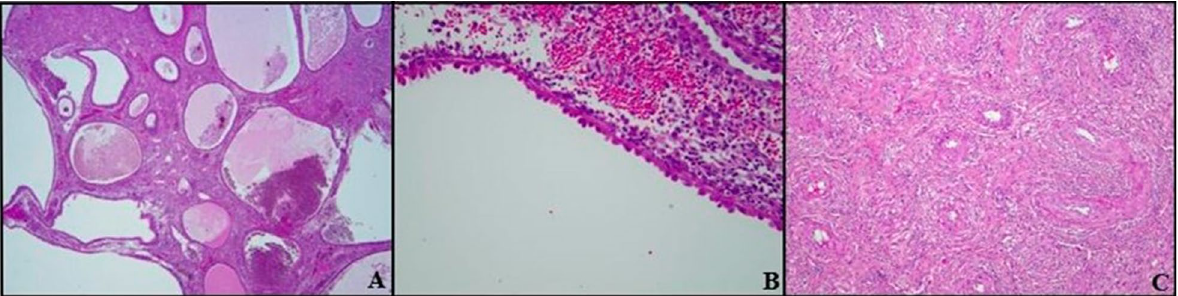
Fig. 1 AMLEC (Hematoxylin and Eosin). A Multilocular cysts, lined by cuboidal epithelial cells H&E X20. B Hobnailing cells with an eosinophilic cytoplasm H&E X20. C Thick-walled dysmorphic blood vessels H&E